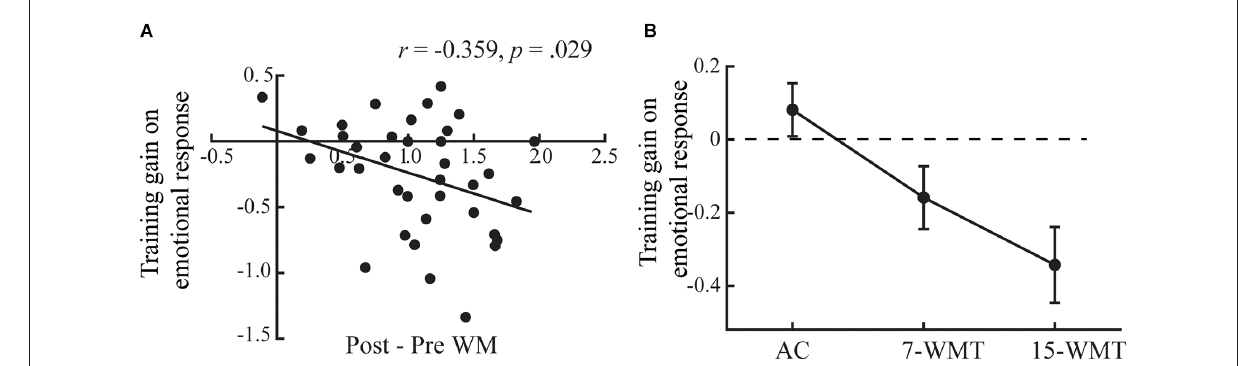
FIGURE5 The results of combination analysis for Experiments 1 and 2. The correlation between training gains on the emotional response (training gain = posttest − pretest emotional response) and changes in WM in the training group (A) . The training gains on emotional response are plotted for three groups (B) . Error bars indicate standard errors. 7-WMT and 15-WMT represent the 7-day and 15-day working memory training groups,